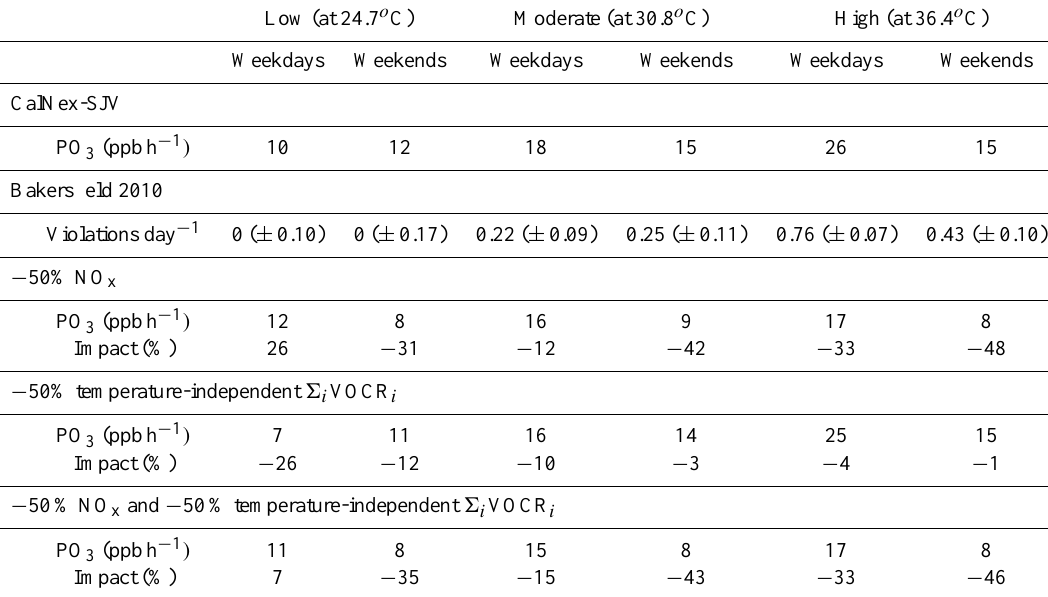
Table 1. P O 3 (ppb h − 1 ) computed with an analytical model parameterized with CalNex-SJV observations (the organic reactivity is equal to VOCR, not 6 i VOCR i ). Row 1: P O 3 calculated at the 2010 average low (24.7 ◦ C), moderate (30.8 ◦ C), and high (36.4 ◦ C) temperatures. Row 2: number of violations of the 8h California O 3 standard in Bakersfield in 2010 (day − 1 ) by temperature and by